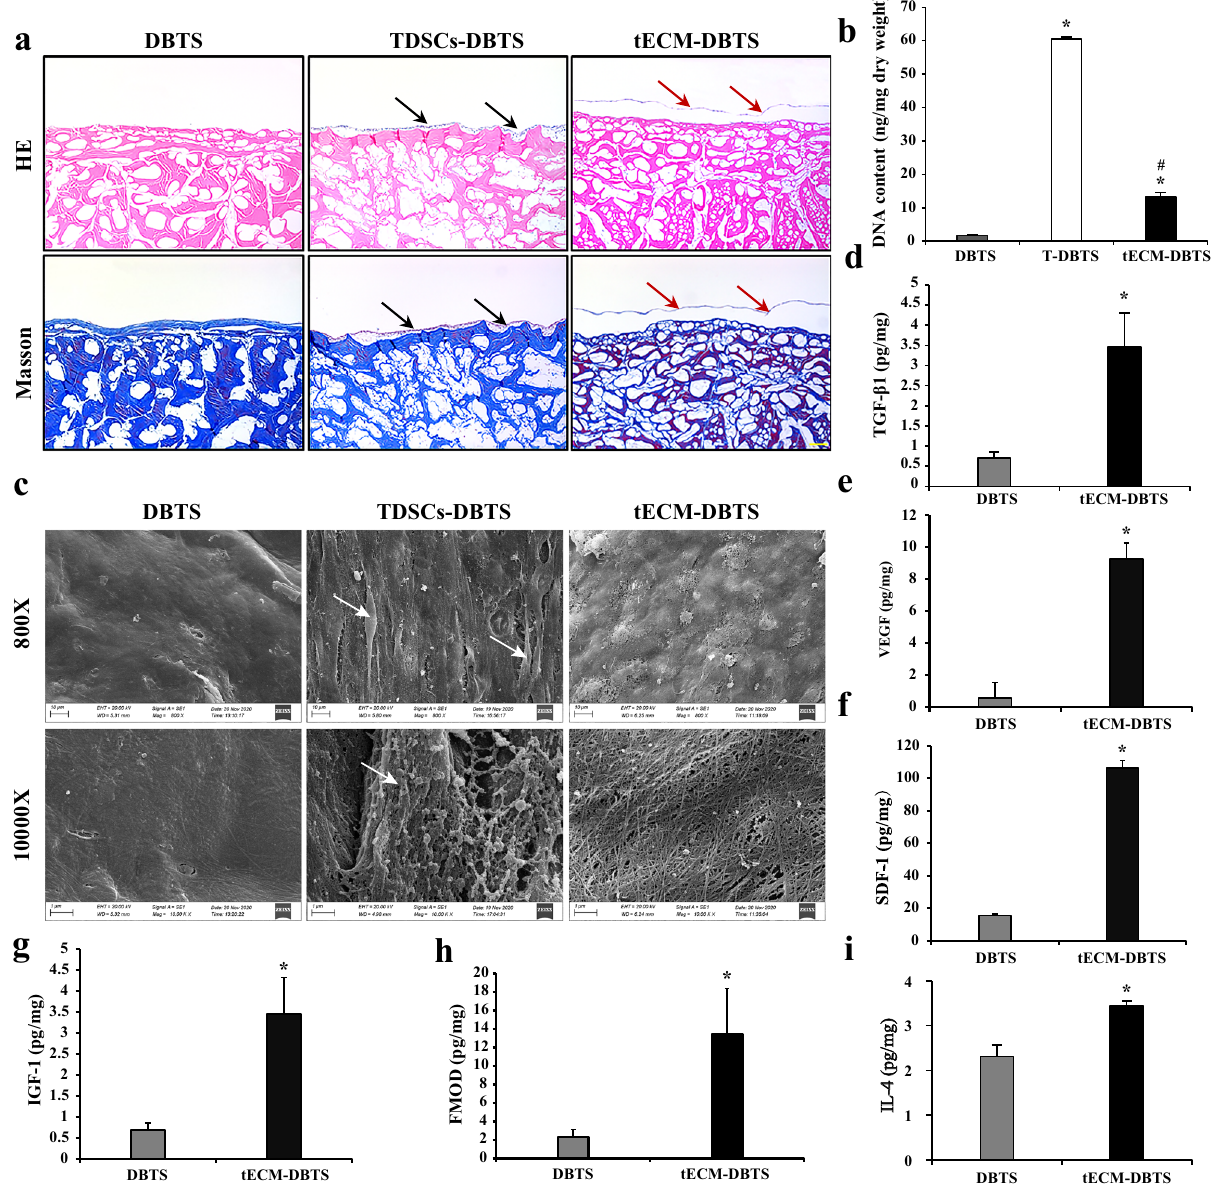
Fig. 2 Preparation and evaluation of the tECM-DBTS scaffold. a HE and Masson staining of the DBTS, TDSCs-DBTS and tECM-DBTS. Black arrows: dense cell sheets produced by TDSCs; Red arrow: ECM secreted by TDSCs. b DNA content before and after the decellularization process as determined by the PicoGreen assay ( n = 4), T-DBTS: TDSCs co-culture with DBTS. c The surface ultrastructure of the DBTS, TDSCs- DBTS and tECM-DBTS was determined by SEM. The white arrow showed that the TDSCs on the DBTS. The content of TGF- β 1 ( d ), VEGF ( e ), SDF- 1 ( f ), IGF-1 ( g ), FMOD ( h ) and IL-4 ( i ) in the DBTS and tECM-DBTS scaffold was determined by ELISA analysis ( n = 4). *Signi fi es a p < 0.05 as compared to the DBTS. #Signi fi es a p < 0.05 as compared to the T-DBTS. Scale bar, a: 100 μ m; b: 10 μ m (800X), 1 μ m cell elongation. The aspect ratio of BMSCs on tECM-DBTS reached nearly 8, which was signi fi cantly higher than that on control and DBTS (Fig. 3g).